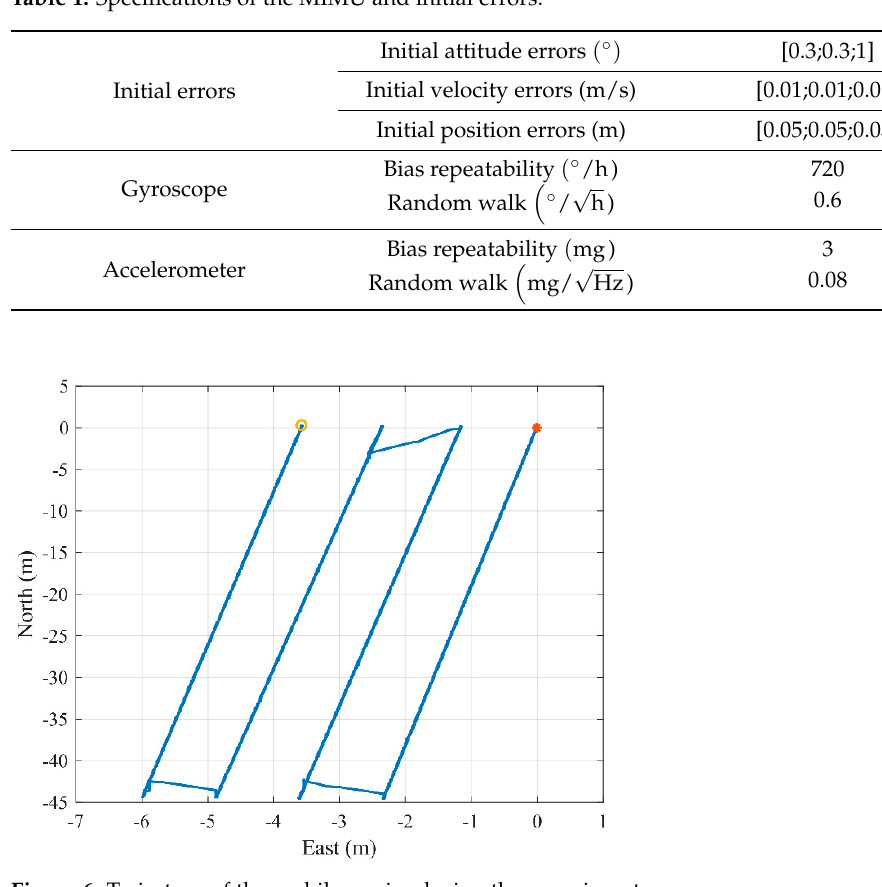
Figure 6. Trajectory of the mobile carrier during the experiment. Table 1. Specifications of the MIMU and initial errors.